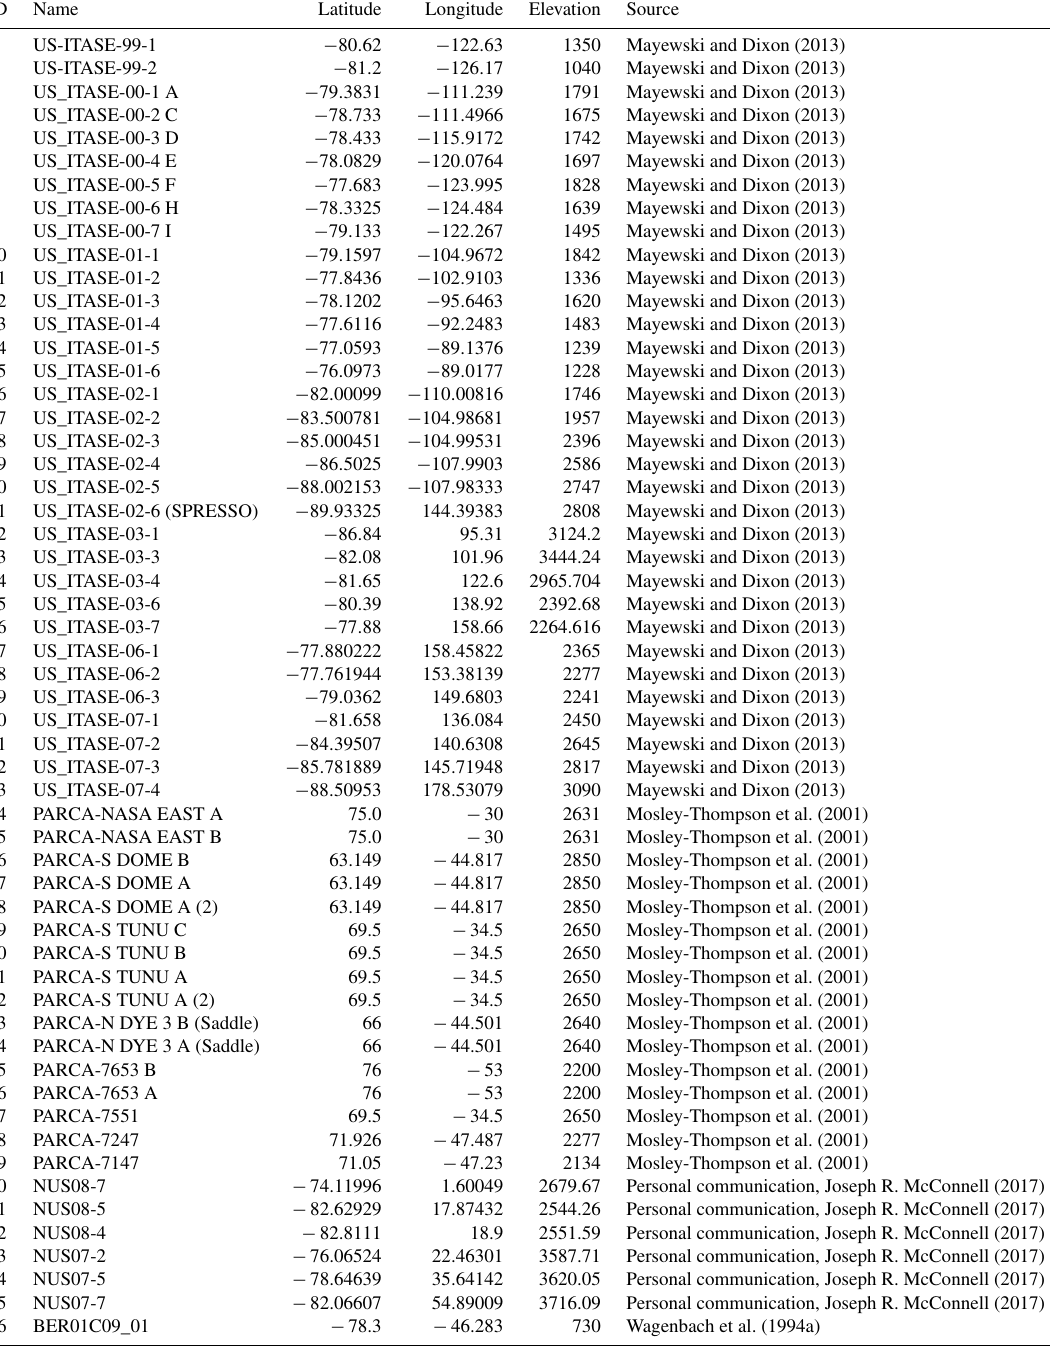
Table A1. Locations and sources of the depth–density profiles used in model